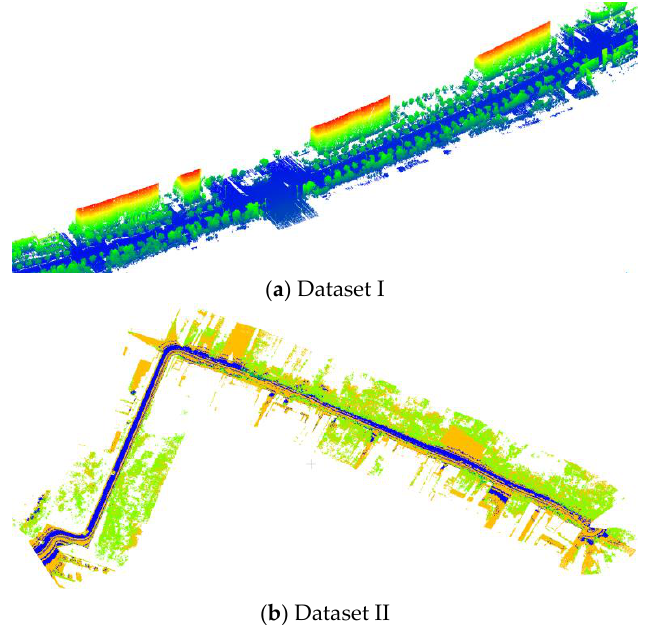
Figure 5. The overview of two experimental datasets. These two experimental datasets are colored by elevation of each point.